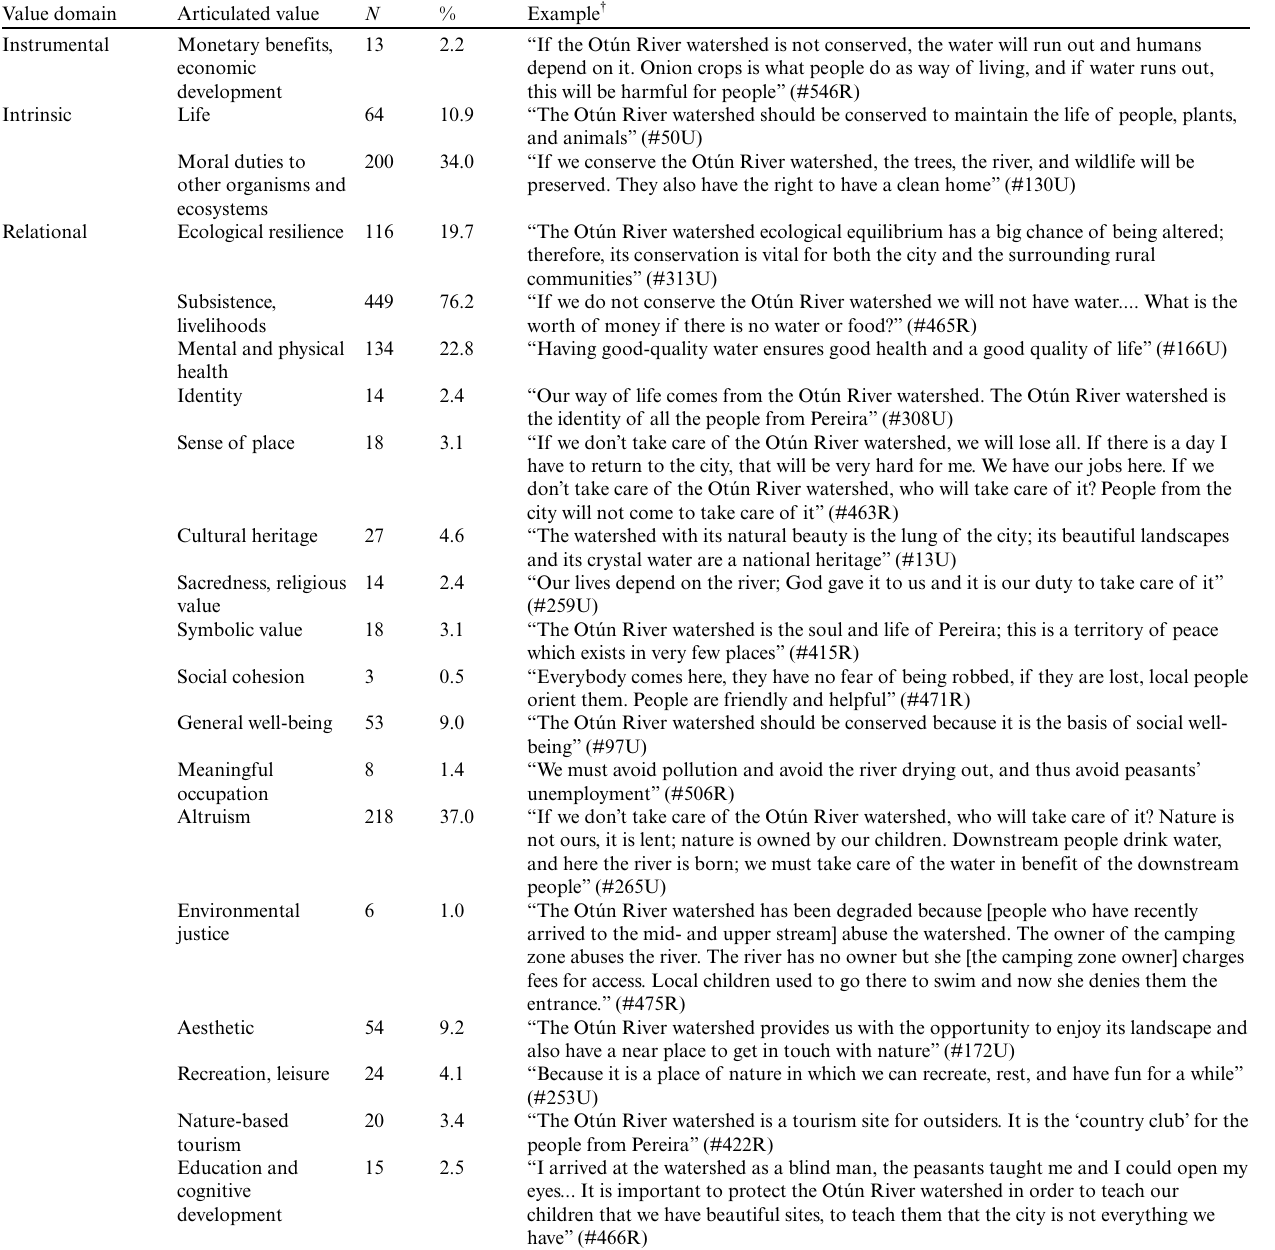
Table 4. Frequency and examples of respondents’ articulated values when mentioning the importance of ecosystems in the mid-upper stream of the Otún River